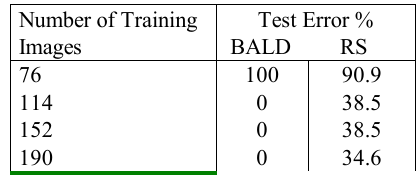
Table 3 . Georgioupoli “Scene 2”: Test errors as resulting from the different acquisition functions a) Bayesian active learning disagreement and b) Random sampling, for the various amounts of training images.